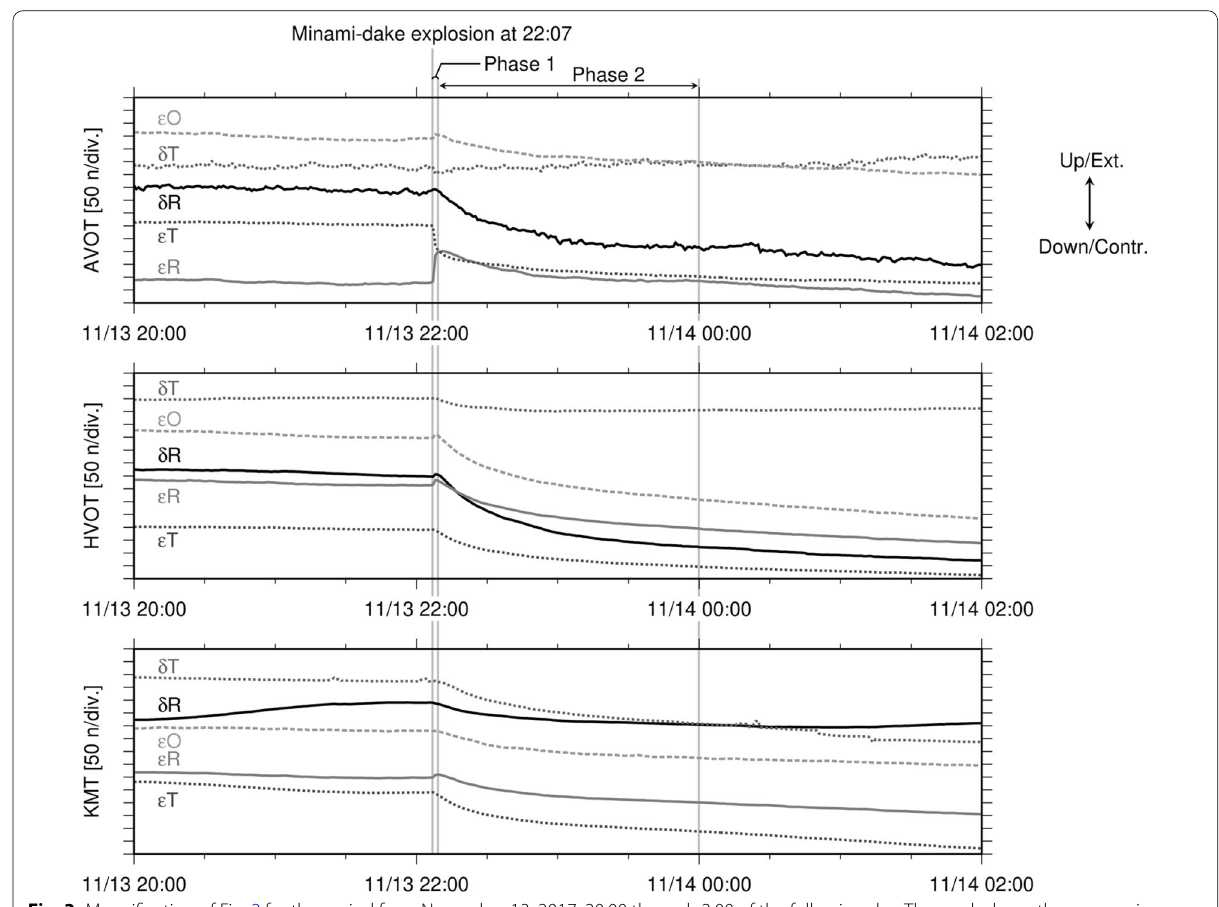
Fig. 3 Magnification of Fig. 2 for the period from November 13, 2017, 20:00 through 2:00 of the following day. The symbols are the same as in Fig. 2a. Phases 1 and 2 are the periods 22:07–22:10 and 22:10–24:00 of November 13, 2017,